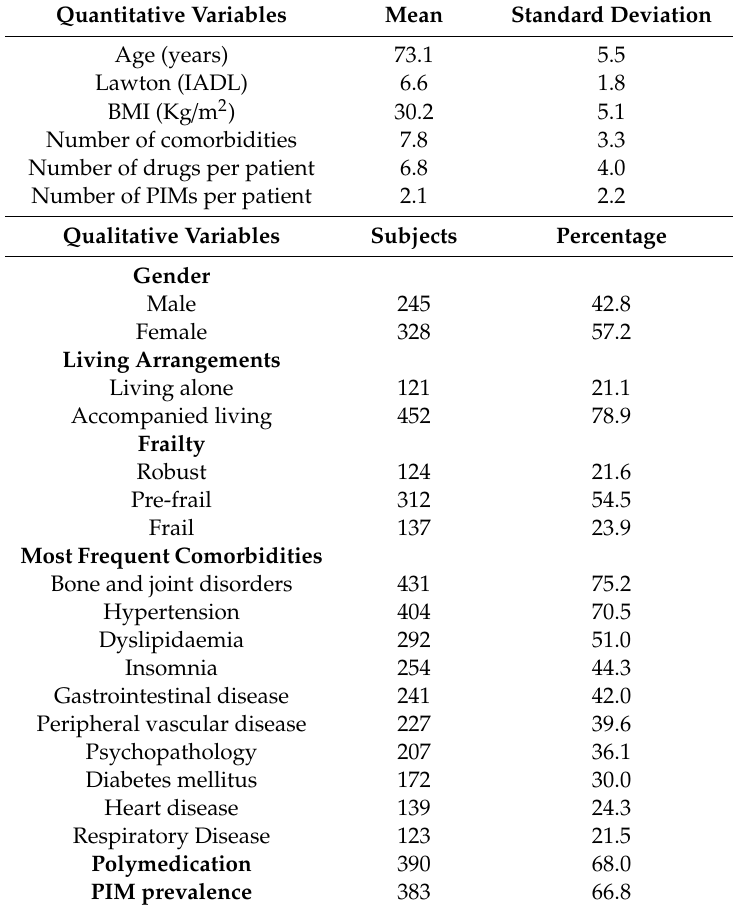
Table 1. Characteristics of study population ( n = 573).